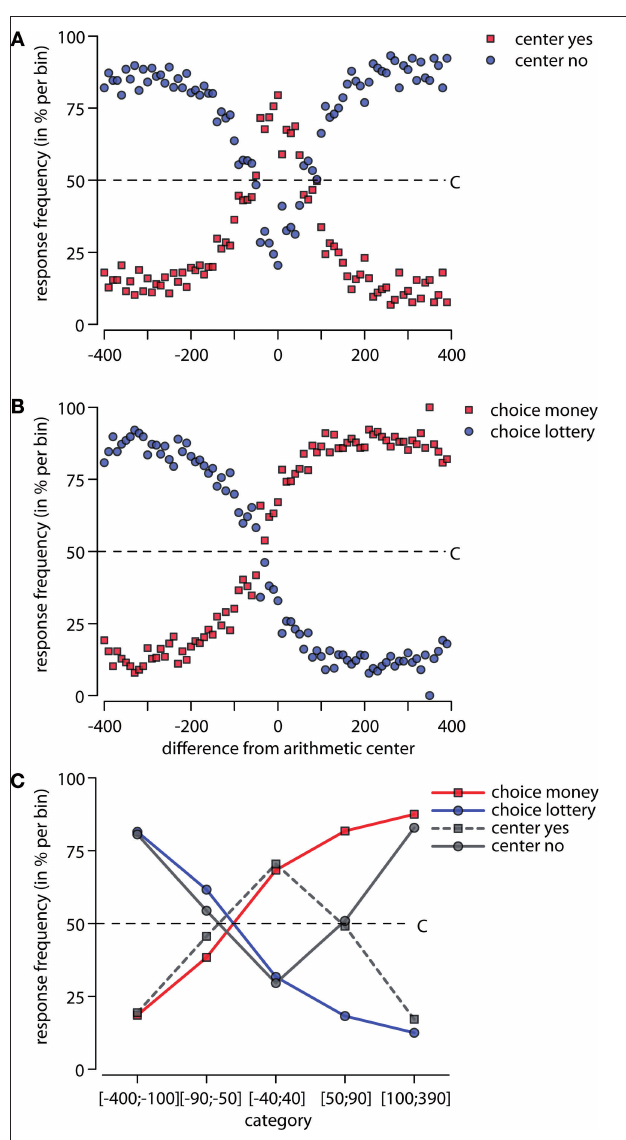
FIGURE 4 | Behavioral data. Mean percentage of choices are shown for the binary lottery (A) and the bisection task (B) . The center is indicated by a dashed line and refers to the indifference point in the bisection task. (C) depicts the cumulated choices per bin for both task. Circles referring to “YES”-, squares to “NO”-responses. Indifference point is indicated by a dotted line. Please note, that statistical comparisons were only calculated for YES